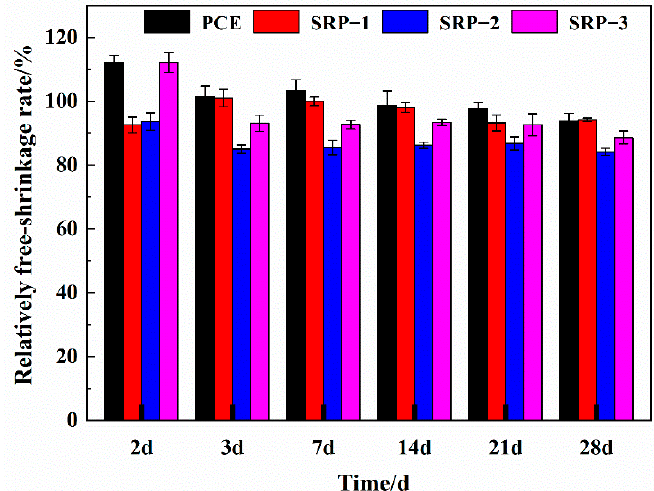
Figure 4. Free − shrinkage rates of mortars containing PCE or SRP. Figure 4. Free-shrinkage rates of mortars containing PCE or